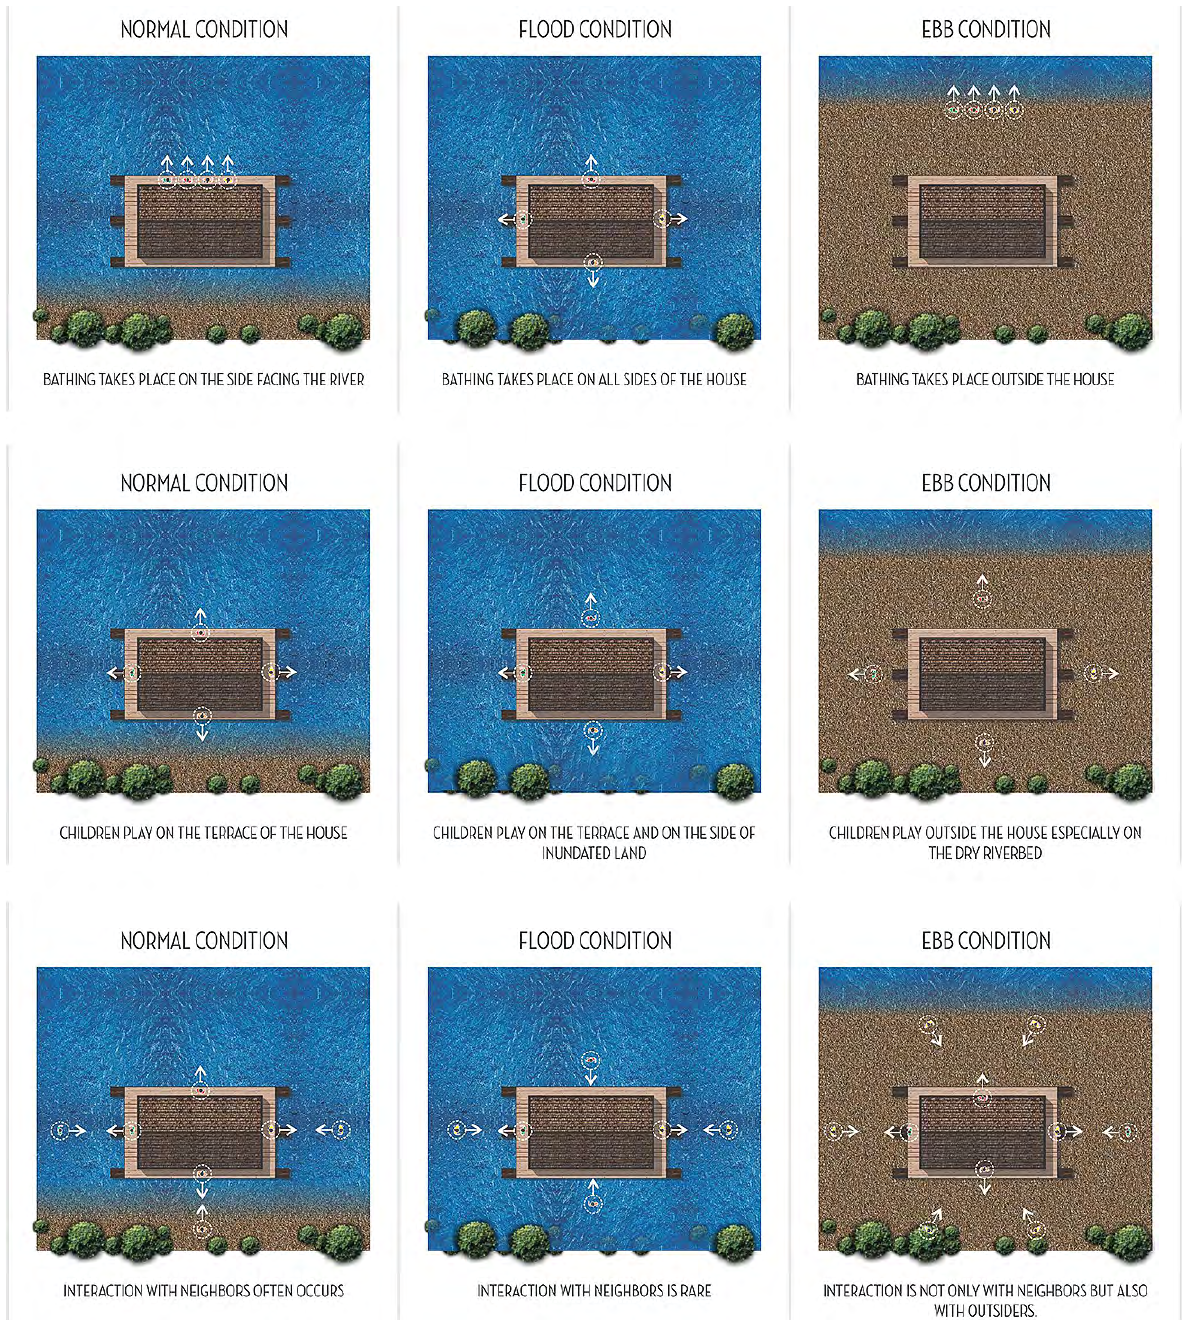
Figure 16. Activity pattern modification in floating